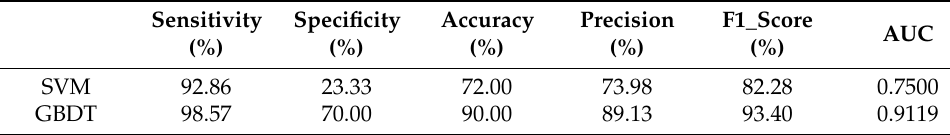
Table 2. The classification result of SVM and